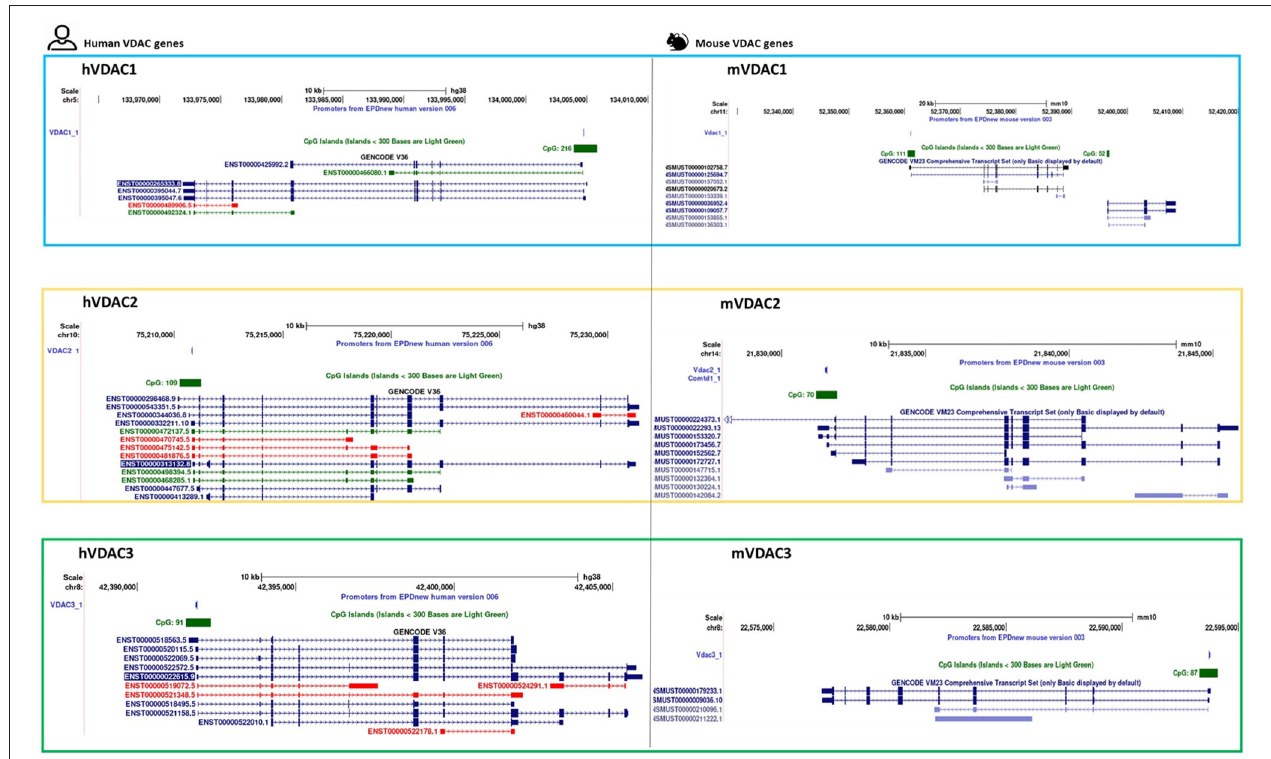
FIGURE 1 | VDAC isoforms in human and mouse. A UCSC schematic overview of transcript variants, showing the location of CpG island and the promoter sequence from EPD v.006 (human) and v.003 (mouse). In the left panel, the colors conventionally used in the GENCODE V36 display of human transcripts show the protein coding sequence in blue, the noncoding mRNA in green, and the retained one in red. In the right panel, the mouse protein gene transcripts are shown in black and dark blue, while other RefSeq transcripts are in light blue according to GENCODE VM23 track